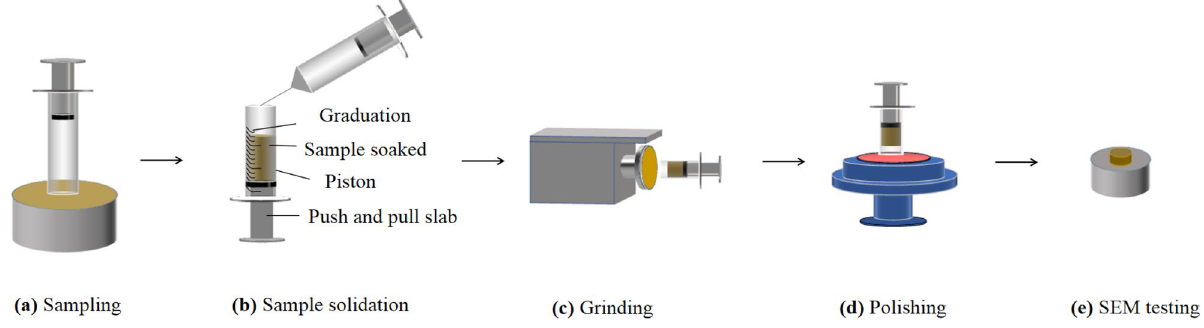
Figure 2. Work flow to generate the